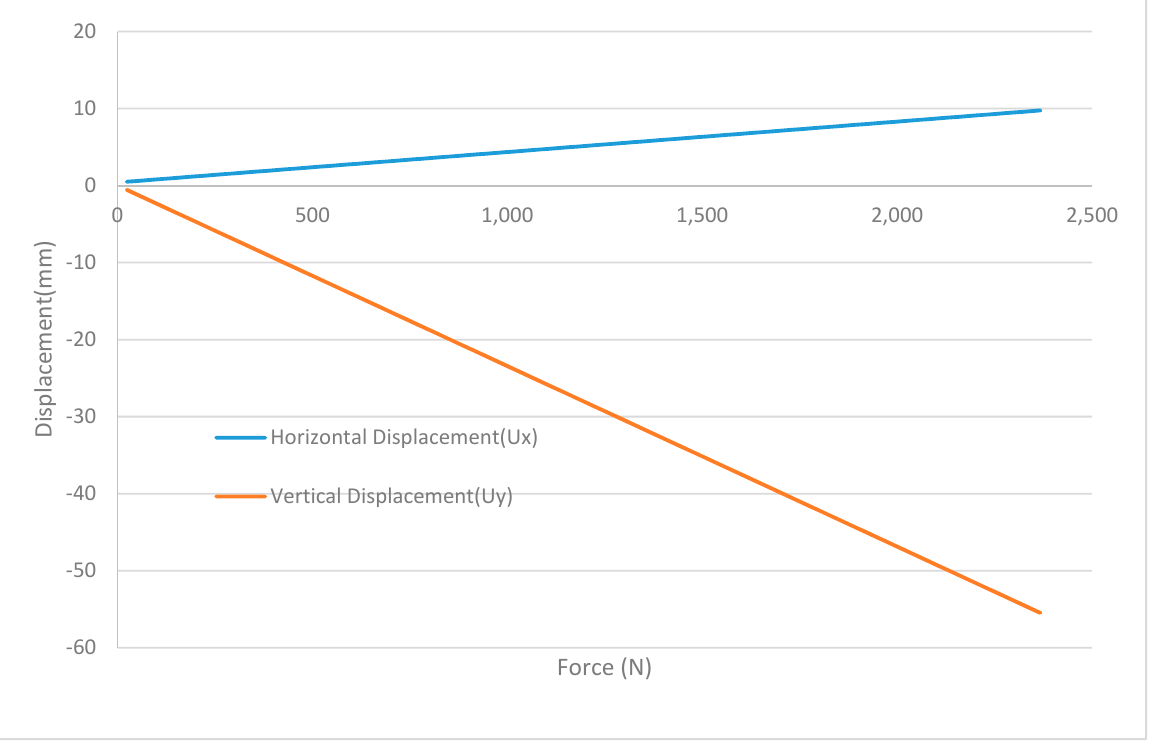
Figure 23. Horizontal and vertical displacements at node 20, element 1126 with coordinate details: ( x = 0, y = 0.25, z = − 4) and 70% FA.